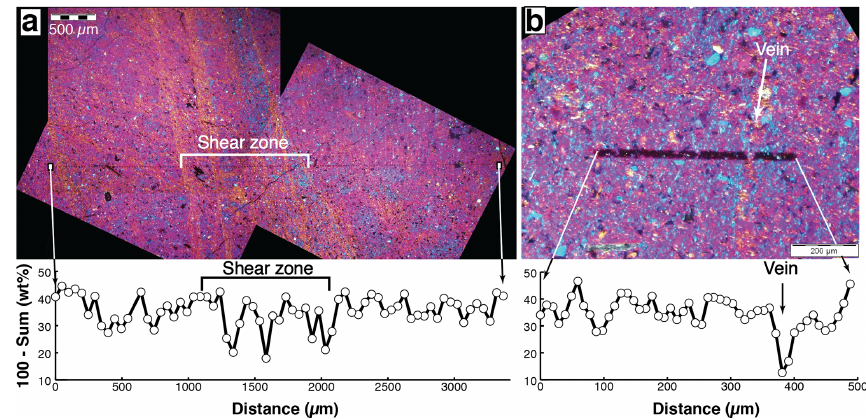
Figure 8. Examples of EPMA profiles of major-element analyses in the clay-size fraction of deformation bands, reported onto optical microphotographs (cross-polarized light with a lambda plate). The quantity displayed in the profiles (100 minus the sum of analyzed major elements) is assumed to represent the concentration of volatile (i.e., not analyzed) elements. (a) Shear zone (sample 4R-3, 73-76). (b) Vein (21R-2, 82-85).